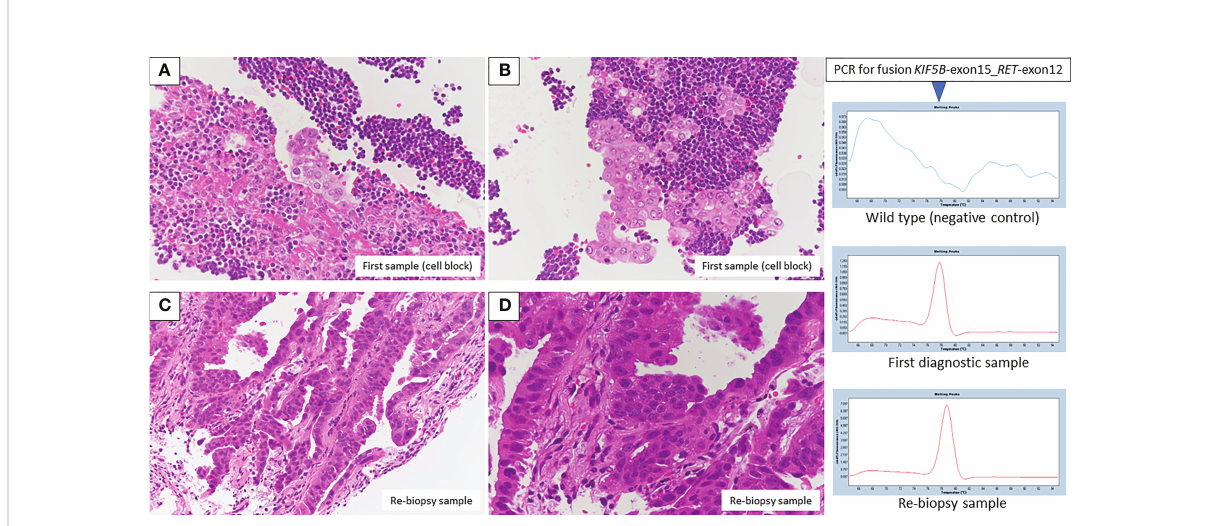
FIGURE 3 Pathologic fi ndings from the fi rst diagnostic cell block showed adenocarcinoma in the presence of many lymphocytes ( A, B , H&E staining, original magni fi cation × 400). A re-biopsy sample also showed adenocarcinoma with an alveolar, ductal structure ( C, D , H&E staining, original magni fi cation×200 and×400, respectively). Fusion KIF5B -exon 15; RET -exon 12 was detected by PCR/NGS assay from fi rst diagnostic specimens, and NGS assay from re-biopsy